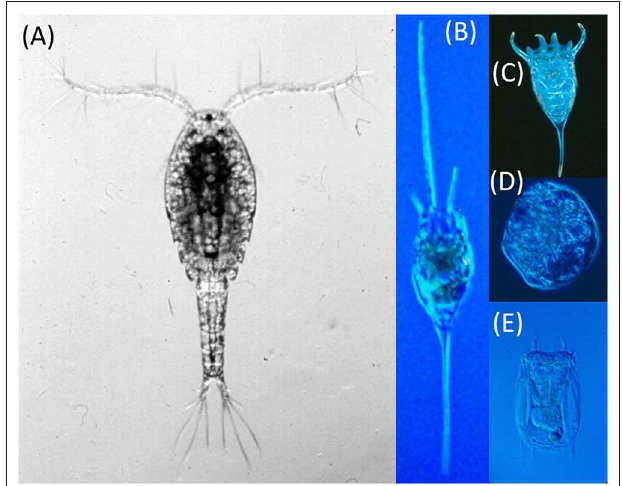
FIGURE 8 | Photographs showing a cyclopoid copepod ( Mesocyclops edax ) (A) and differential defenses of rotifers against cyclopoid predation including the spined rotifers Kellicottia (B) and Keratella (C) that either increased or did not change in abundance, respectively, and the soft-bodied rotifers Gastropus (D) and Polyarthra (E) that showed significant declines. Size of rotifers magnified relative to the copepod to show